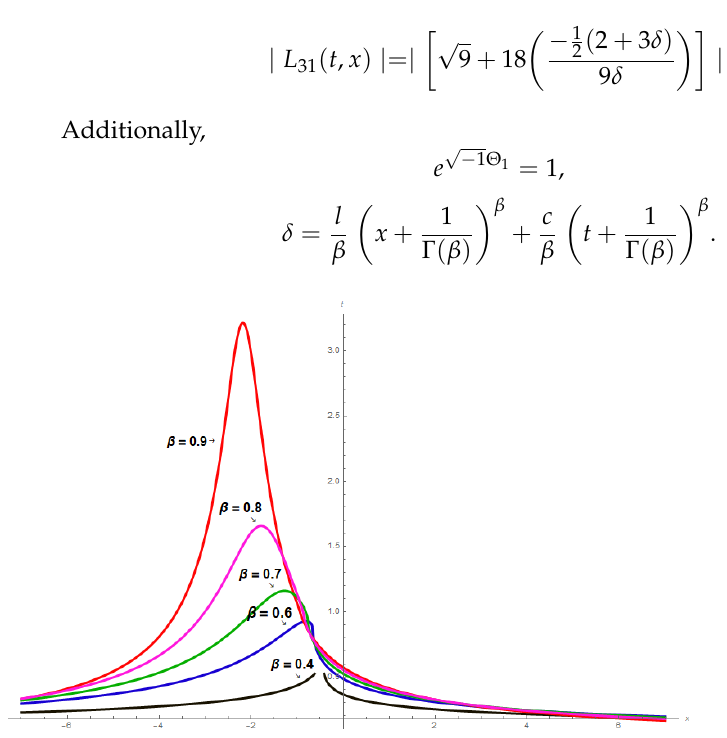
Figure 3. The 2D graphs of dark–bright solitary-wave solution, i.e., | L 18 | across different values of β . Figure 4: The analytical solution | L 31 ( t , x ) | is based on the constant values of the proposed parameters. | L 31 ( t , x ) | is graphically illustrated to demonstrate the potentiality of the EDAT with the fractional beta derivative as follows. Here is a visual showing a 2D plot spanning the range ( − 0.7, 0.7 ) for various values of β associated with parameters, √ = 9, β = 0.9 (red), such as ρ = e , l = 2, c = 1, α = − 1, s 1 = 1 , µ 1 = 1 , ζ 1 = 9, ν 2 1 2 4 β = 0.6 (blue), β = 0.7 (green), β = 0.8 (magenta), β = 0.5 (black). Hence, | L 31 ( t , x ) | becomes